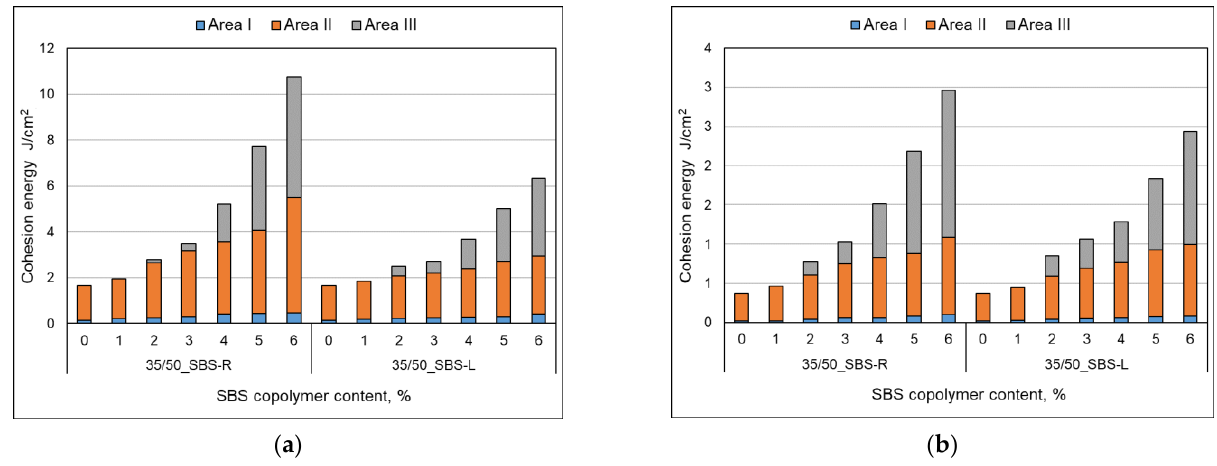
Figure 16. Cohesion energy of bitumens during stretching, taking account of the type of strain (as per Figure 2b), mean values, ( a ) bitumen 35/50, ( b ) bitumen 160/220.